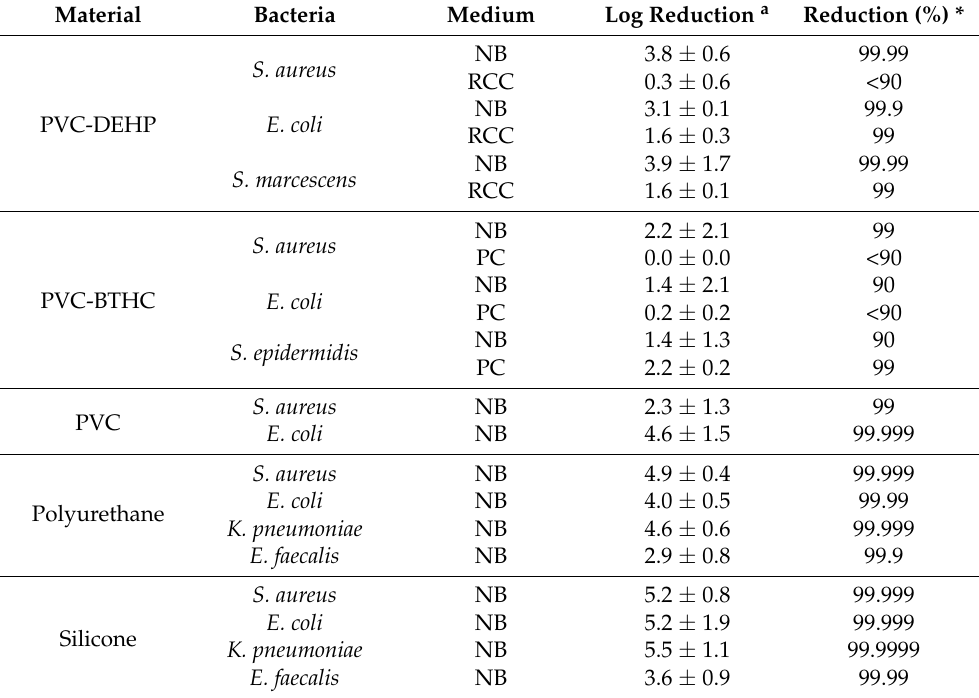
Figure 3. Logarithmic bacterial growth (mean ± standard deviation) in nutrient broth (1/500) with an inoculum of 6 × 10 5 CFU/mL after 24 h in contact with untreated (reference) and treated polymeric materials (MAAC) ( n = 3). S. a. = Staphylococcus aureus ; E. c. = Escherichia coli ; S. m. = Serratia marcescens ; S. e. = Staphylococcus epidermidis ; K. p. = Klebsiella pneumoniae ; E. f. = Enterococcus faecalis . * Signif- icant growth difference between the reference and the MAAC condition (Student t -test, α = 0.05, * p -value < 0.05). Table 2. Bacterial reductions of MAAC-treated polymeric materials.